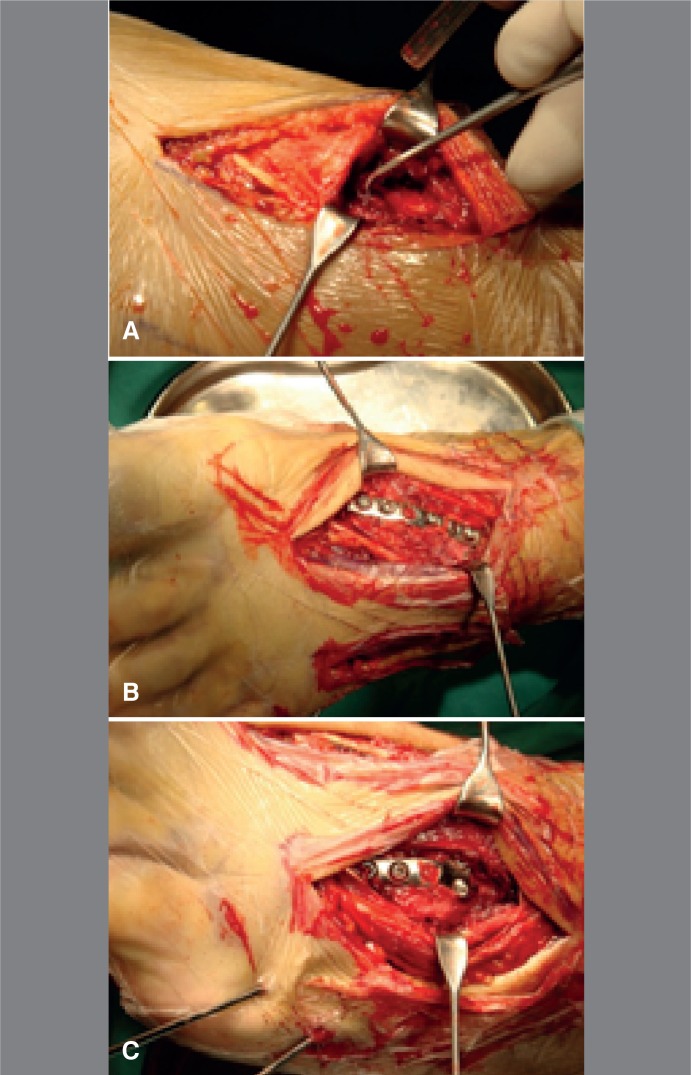
(A) The periosteum of first TMT joint is incised longitudinally to expose the dislocation, as well as the second TMT joint and the intercuneiform articulation. (B) The first TMT joint is fixed with a dorsal miniplate. (C) The third TMT joint is also fixed by a suitable miniplate.